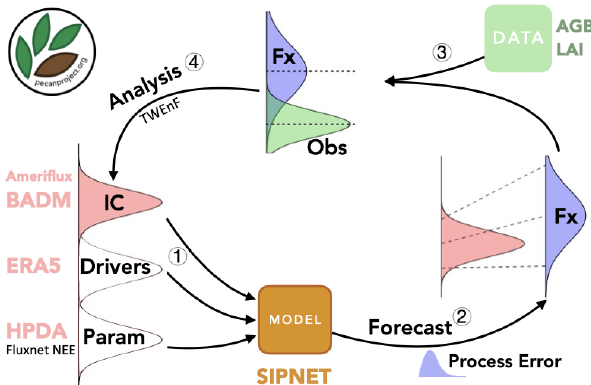
Figure 3. PEcAn state data assimilation system: forecast–analysis cycle. Step 1: uncertainty propagation. Step 2: forward forecast. Step 3: data preparation. Step 4: data